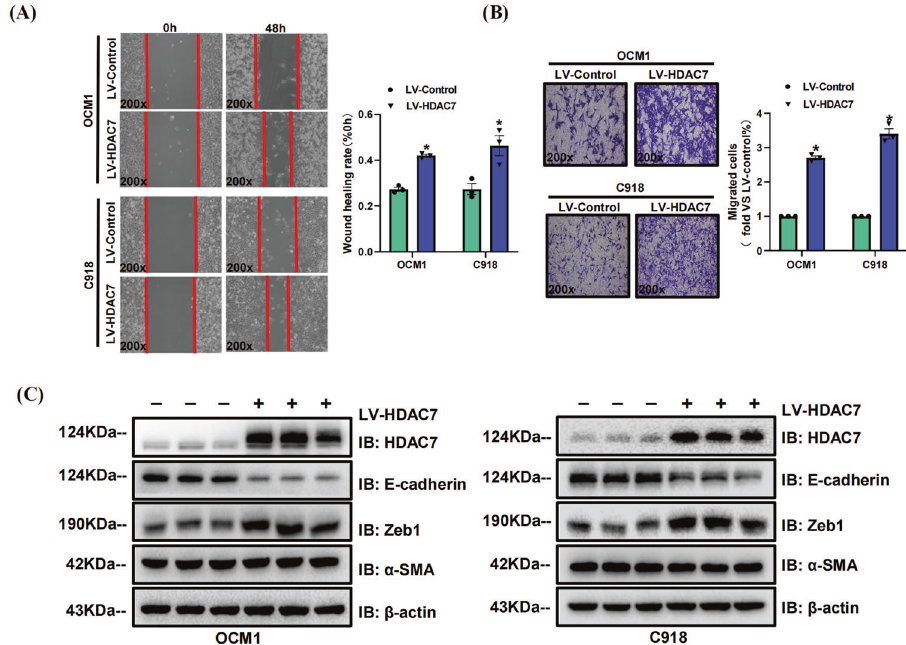
Fig. 4 HDAC7 overexpression facilitates OCM1 and C918 cell metastasis in vitro. A Typical pictures (×200) and statistical analysis of the wound healing assay. In wound healing assays, the migratory capacity was shown as the mean scratch area. The initial scratch area (0 h) was set to 100%. B Typical pictures (×200) and statistical analysis of the transwell assay. C Typical Western blot results of HDAC7, E-cadherin, Zeb1, and α -SMA in LV-HDAC7 OCM1/C918 and LV-Control OCM1/C918 cells. β -actin was used as an internal control. Data are exhibited as the mean ± SD. Student ’ s t -test, * P < 0.05 vs. LV-Control group. Abbreviations: LV lentivirus, HDAC7 histone deacetylase